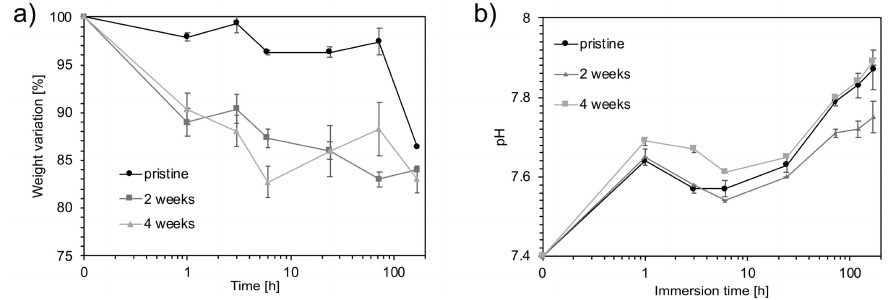
Figure 7. ( a ) Weight variations evaluated after 1 h, 3 h, 6 h, 24 h, 3 d, and 7 d of immersion in simulated body fluid (SBF) at each aging time point: 0, 2, and 4 weeks. ( b ) pH evaluations performed after 1 h, 3 h, 6 h, 24 h, 3 d, 5 d, and 7 d of immersion in SBF at each aging time point: 0, 2, and 4 weeks.